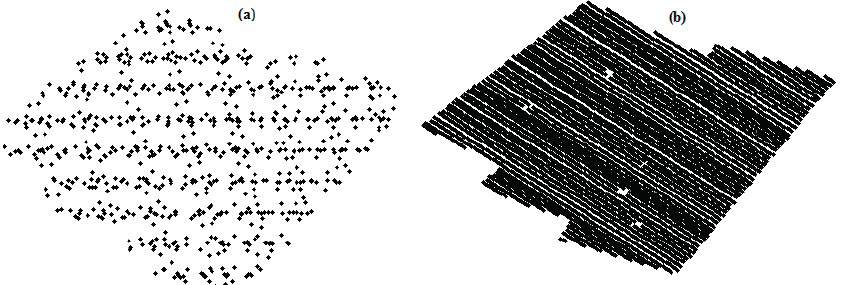
Figure 1. Comparison of the densities of the ALS point clouds. ( a ) 0.8 points/m 2 ; ( b ) 8 points/m 2